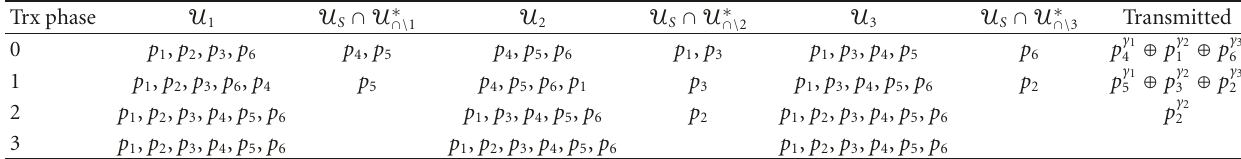
Table 2: Scheduling solution for the setup of Figure 12. tx k indicates the transmission phase. Each phase corresponds to the complete transmission of a native packet (or a sum of native